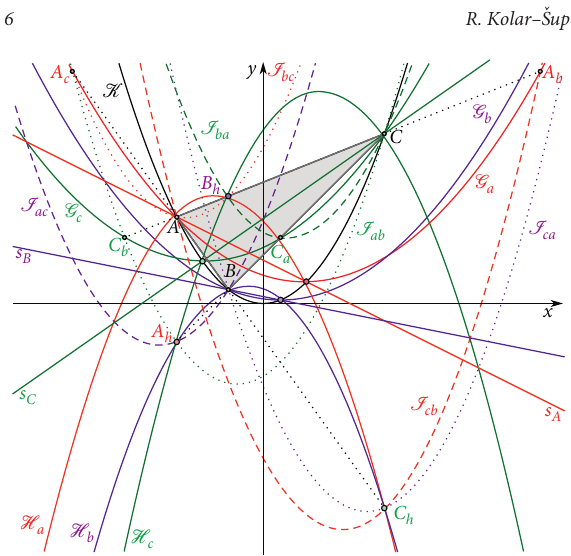
Figure 3: Visualization of statements of Theorems